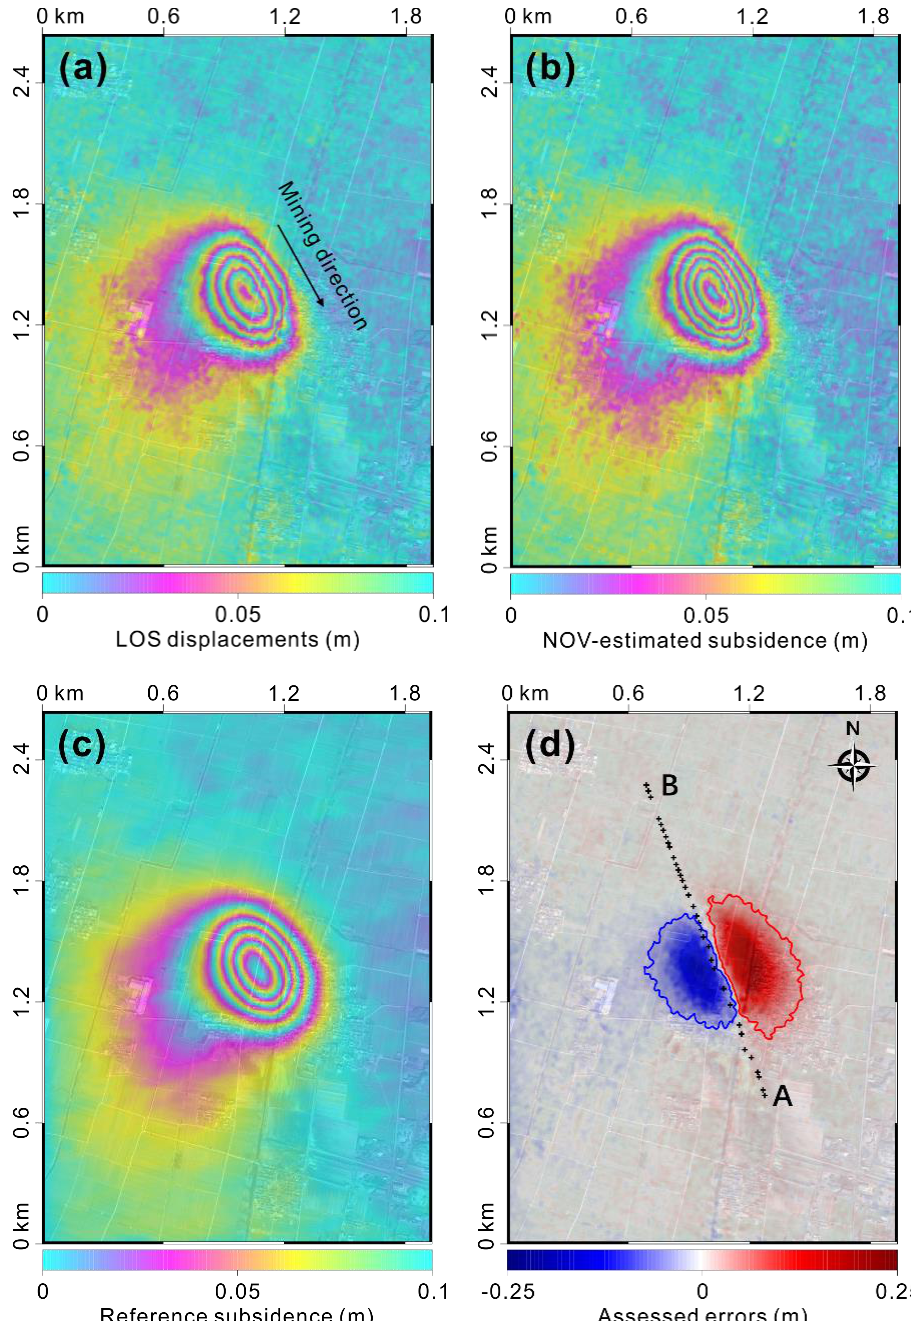
Figure 1. ( a ) InSAR-derived LOS displacements over the Qianyingzi coal-mining area after interpolation over low-coherent areas; ( b ) NOV-estimated mining subsidence; ( c ) Reference subsidence solved by the SIP method; ( d ) Assessed errors of the NOV-estimated mining subsidence using the presented pixel-wise method. The black crosses in ( d ) denote the geographic locations of in situ observation points for the following accuracy validation. The background map is the optical image over the region of